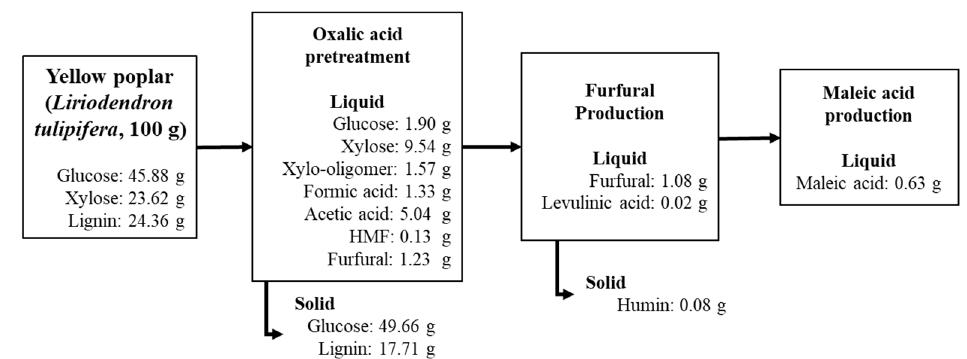
Figure 7. Mass balance for maleic acid production from lignocellulosic biomass.